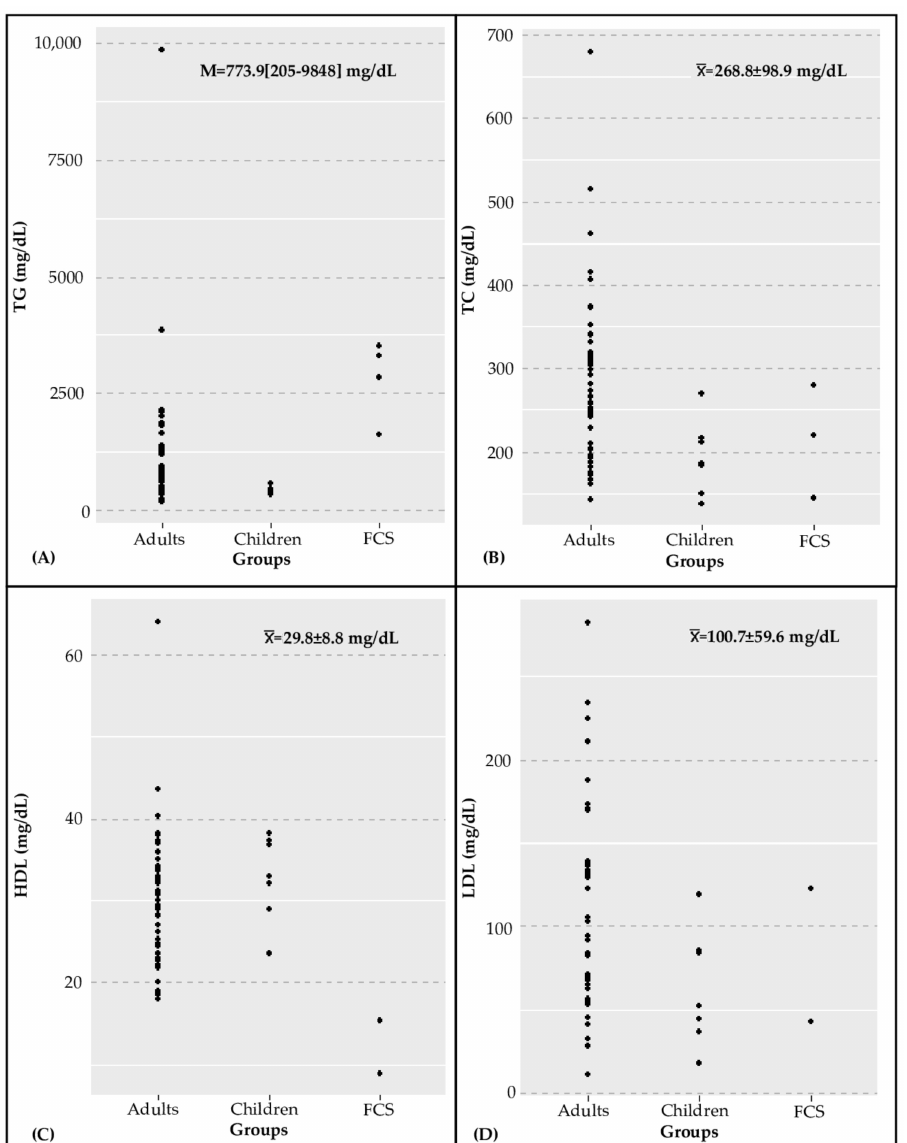
Figure 1. Scatter plot of lipid profile of 58 patients with hypertriglyceridemia. ( a ) Triglyceride (TG); median and range values. ( b ) Total cholesterol (TC); ( c ) High-density lipoprotein; and ( d ) Low-density lipoprotein; mean and standard deviations of these last three variables are